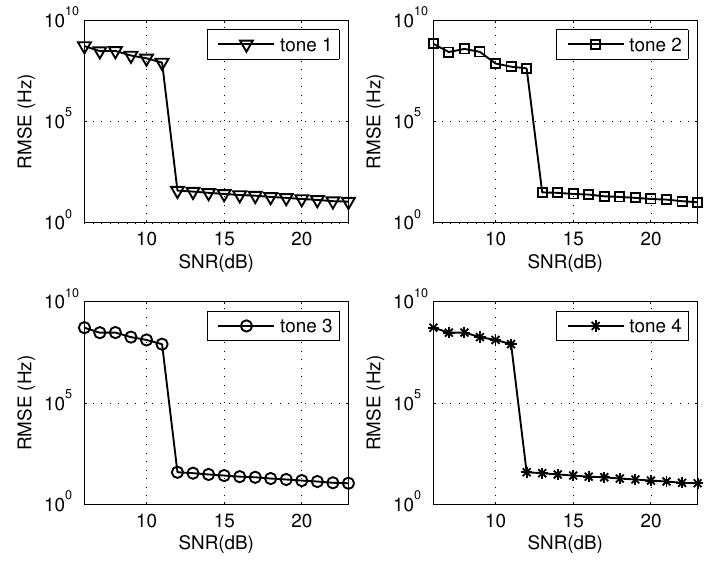
Figure 7. RMSE results of four tones utilizing the traditional